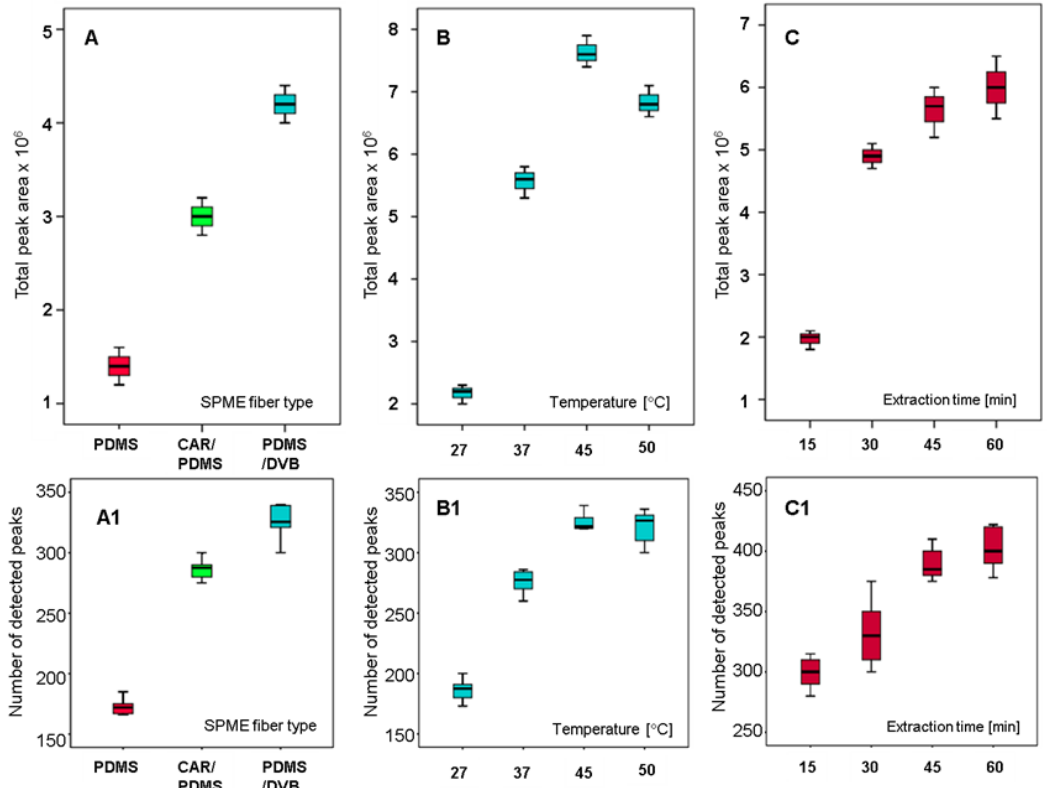
Figure 1. Optimization of extraction parameters, including comparison of PDMS/DVB, Carboxen/PDMS and PDMS coatings for extraction of VOC (part ( A , A1 )), different extraction temperatures (part ( B , B1 )) and extraction time (part ( C , C1 )). The boxplots in the upper were drawn according with total peak area of extracted VOCs (subfigures A – C ), while the bottom box plots represent the number of extracted VOCs (subfigures A1 – C1 ).